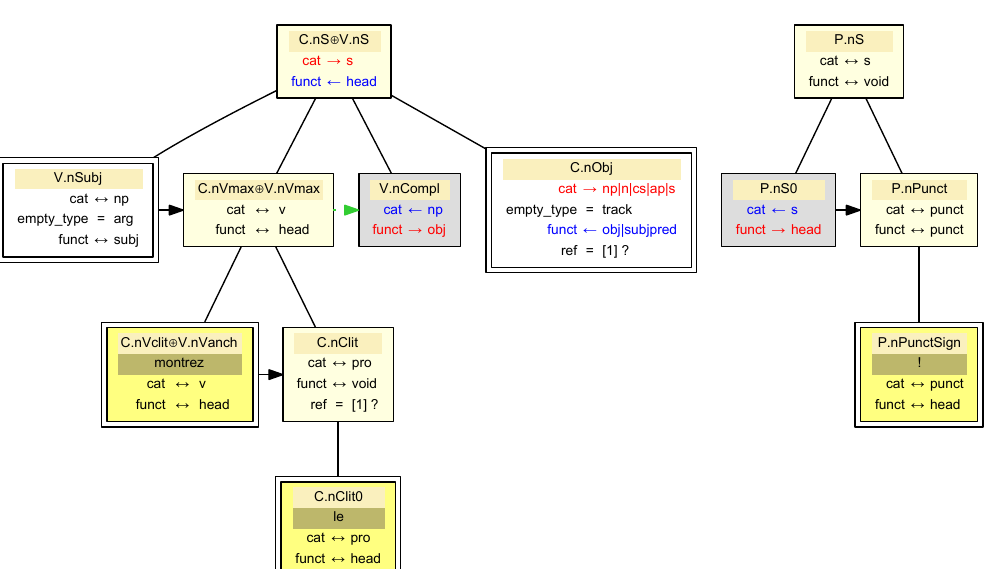
Figure 4: PTD after a first merging step in the parsing of the sentence montrez-le!